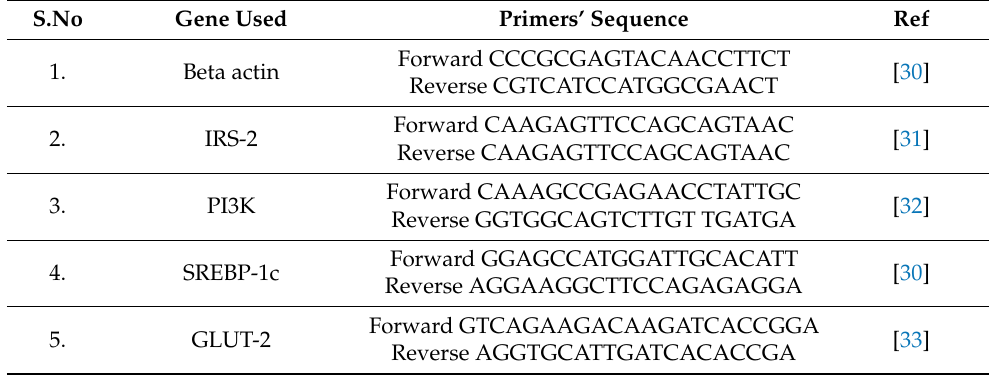
Table 1. Details of primer